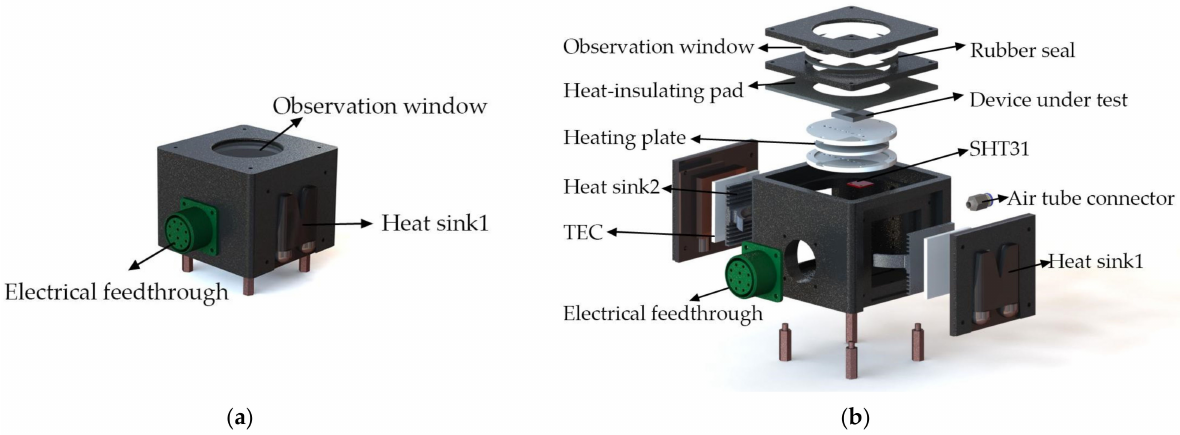
Figure 2. ( a ) Schematic illustration of the assembled test chamber, ( b ) schematic illustration of the exploded structure of the test